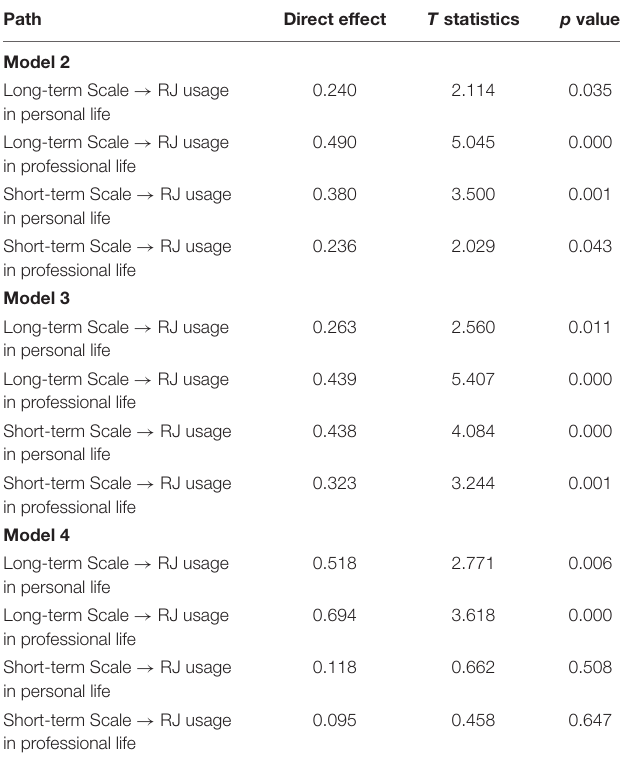
TABLE 5 | Significance analysis of the direct effects for each